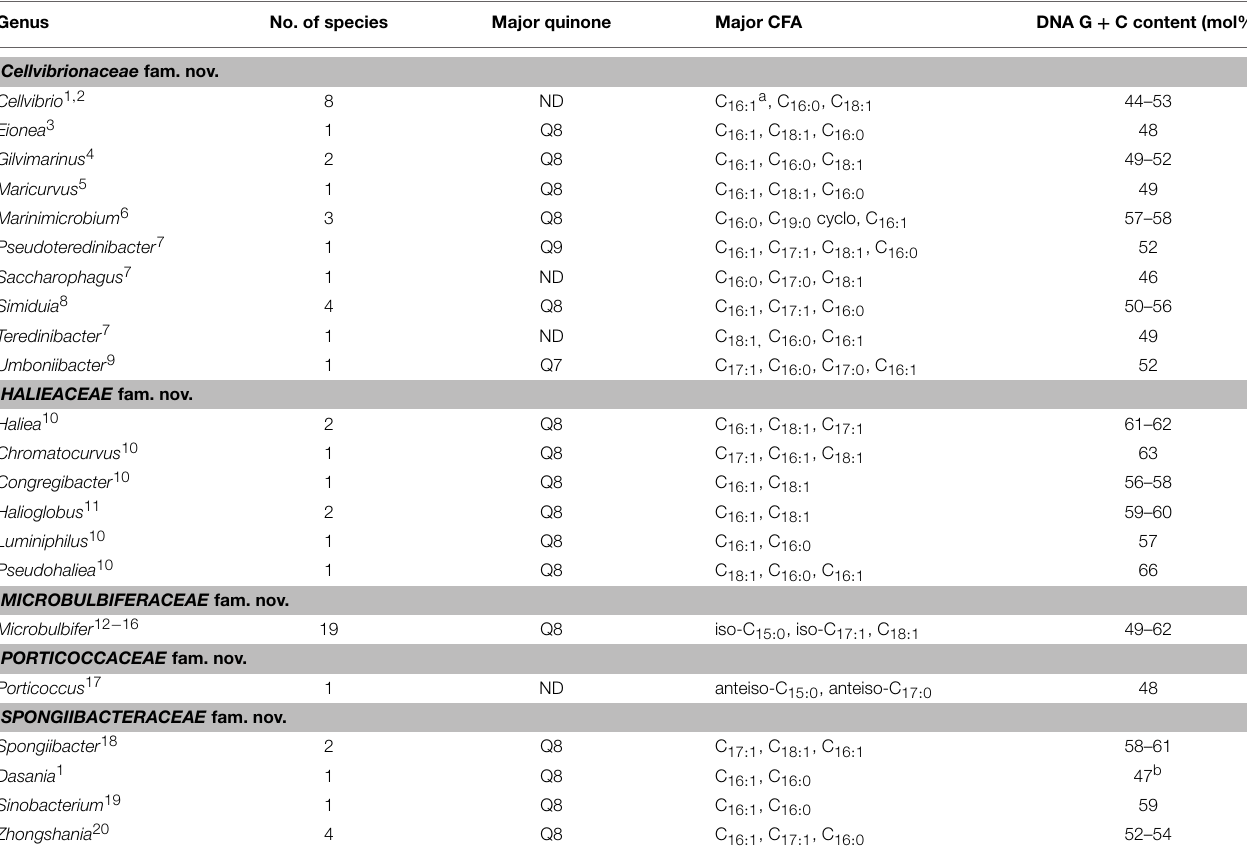
TABLE 2 | Chemotaxonomic traits of genera with a proposed affiliation to the novel order Cellvibrionales . Genus No. of species Major quinone Major CFA DNA G + C content